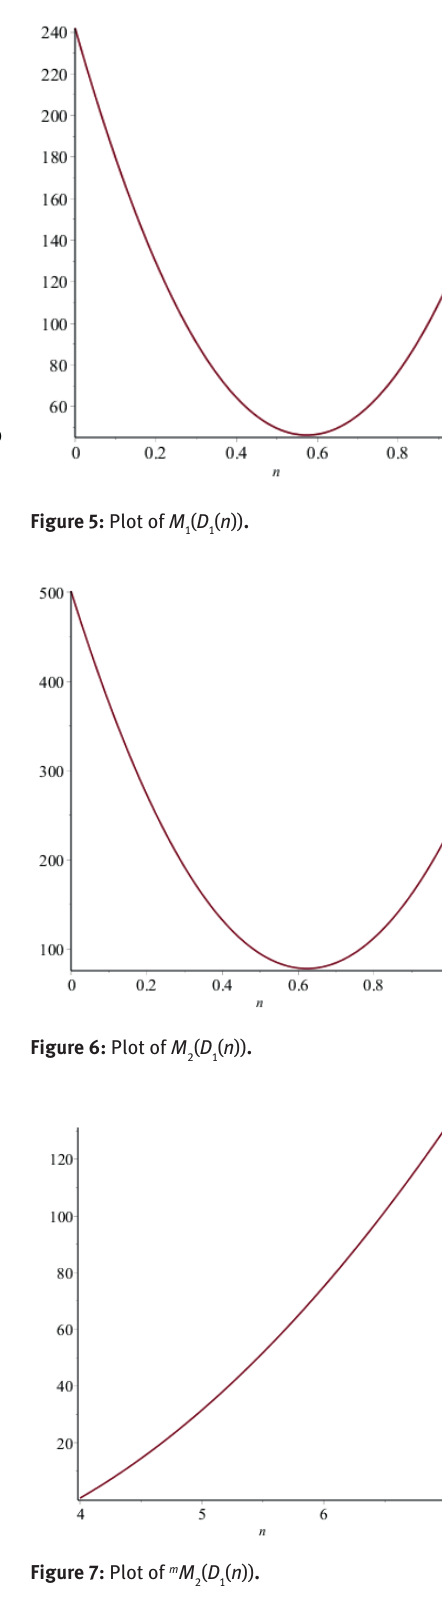
Figure 7: Plot of m M